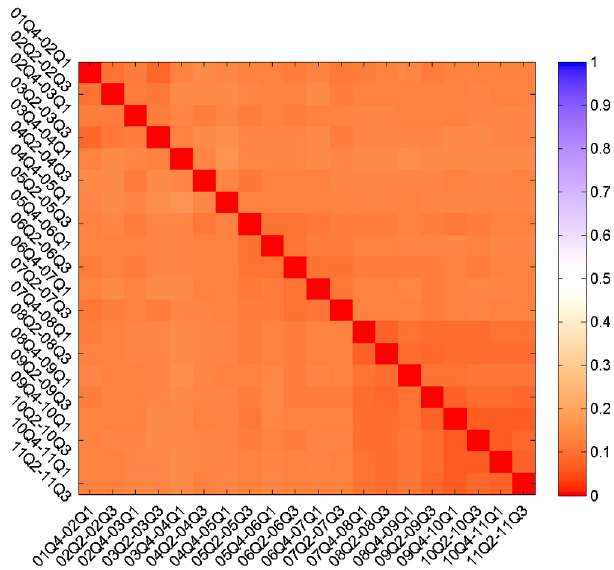
FIG. 19. Temporal trend of VI showing the similarity in community structure for the different algorithms over a six- month sliding window spanning the time frame from October 2001 to October 2011. (The Potts algorithm is shown by green squares, the Louvain algorithm by orange circles, and the spectral algorithm by blue triangles.)